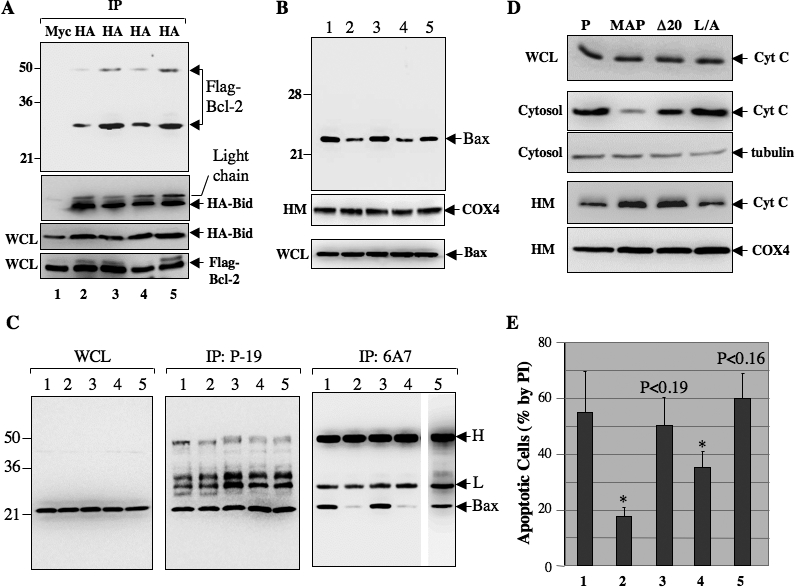
vMAP Interacts with Bcl-2 and VDAC1 in a Genetically Separable Manner(A) vMAP interaction with Bcl-2, but not with VDAC1, enhances Bcl-2 binding to Bid. NIH3T3 stable cells expressing puro (lane 2), vMAP (lanes 1 and 3), vMAPΔ20 (lane 4), or vMAP L/A (lane 5) were transfected with plasmids containing Flag-Bcl-2 and HA-Bid. At 48 h post-transfection, cells were harvested and WCLs were used for immunoprecipitation with anti-HA (Bid), followed by immunoblotting with HRP-conjugated anti-Flag (Bcl-2, top panel) or anti-HA antibody (middle panel). WCLs were analyzed by immunoblotting with anti-HA (Bid) and anti-Flag (Bcl-2) antibodies (bottom two panels). Anti-Myc antibody in lane 1 was included as a negative control.(B) vMAP-Bcl-2 interaction but not vMAP-VDAC1 interaction is required to inhibit Bax mitochondrial translocation. NIH3T3 stable cells were treated with ST (1 μM) for 4 h, and mitochondrion-enriched HMs (20 μg) were analyzed by immunoblotting with anti-Bax or anti-VDAC antibody (top two panels). WCLs were used for immunoblotting with anti-Bax (bottom panel). Lane 1, NIH3T3/puro; lane 2, NIH3T3/vMAP; lane 3, NIH3T3/vMAPΔ20; lane 4, NIH3T3/vMAP L/A; lane 5, NIH3T3/vMAPΔ20&L/A.(C) vMAP-Bcl-2 interaction but not vMAP-VDAC1 interaction is required to inhibit the mitochondrial translocation of Bax. NIH3T3 cells expressing wt vMAP or mutants thereof were stimulated with ST (1 μM) for 4 h. WCLs were precipitated with anti-Bax P-19 polyclonal antibody or 6A7 monoclonal antibody, followed by immunoblotting with 6A7 monoclonal antibody as described in Figure 6A. The content of the lanes is same as described in (B). H and L indicate the heavy and light chains of immunoglobulin, respectively.(D) vMAP interactions with Bcl-2 and VDAC1 are required to efficiently inhibit cytochrome c release. NIH3T3 cells containing vector (P), vMAP, vMAPΔ20 (Δ20), or vMAP L/A (L/A) were treated with ST (1 μM) for 4 h. Mitochondrion-enriched HM and cytosolic fractions (Cytosol) were obtained by centrifugation as described in Materials and Methods. Each fraction (20 μg) was resolved by SDS-PAGE and analyzed by immunoblotting with antibodies to cytochrome c (Cyt C), COX4, and tubulin (cytosolic fraction only).(E) Roles of vMAP interactions with Bcl-2 and VDAC1 in anti-apoptosis. NIH3T3 cells were treated with ST (1 μM) for 16 h and subsequently stained with PI for flow cytometry. Data represent three independent experiments. Error bars indicate standard deviation with (*) p < 0.05 relative to control (NIH3T3/puro cells, 1) as calculated by Student's t-test. The content of the lanes is same as described in (B).